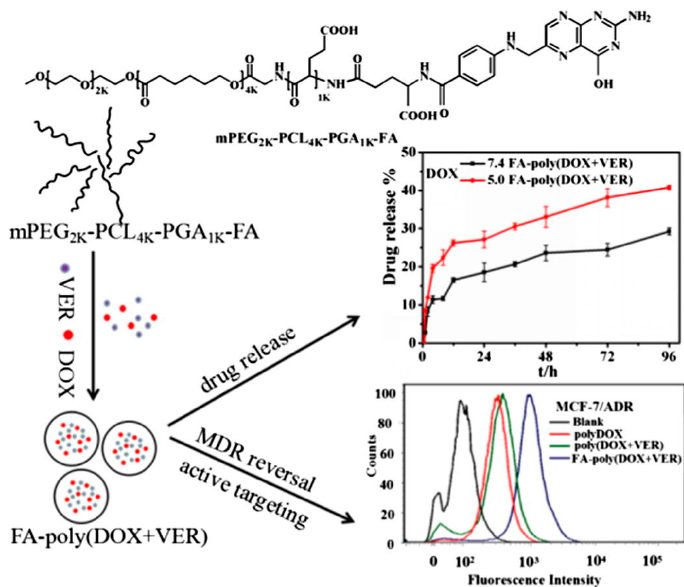
Figure 2. Folate-modified pH-sensitive co-delivery system of FA-poly(DOX+VER) polymer assembly exhibits obvious pH-sensitivity, high active targeting ability, strong multidrug resistance reversal and